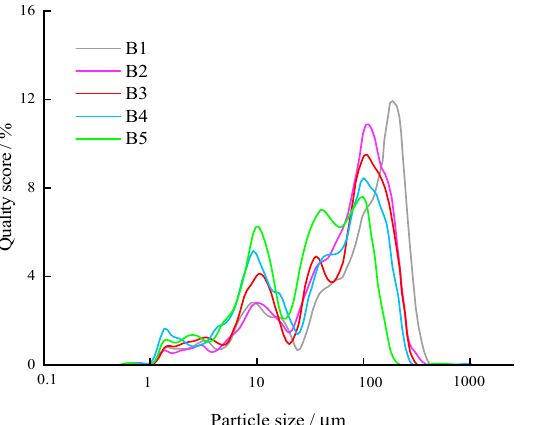
Figure 11. Coal powder particle size distribution under closure pressure 5 MPa and flow rate 100 mL/min.